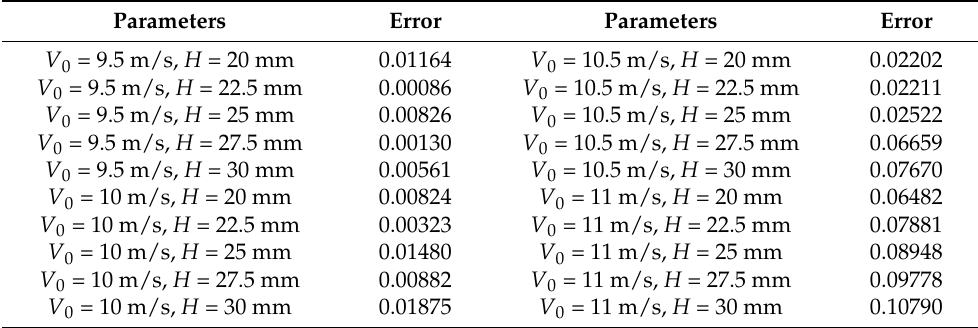
Table 4. Errors between the numerical simulations and experimental data for the principal curvature of the formed